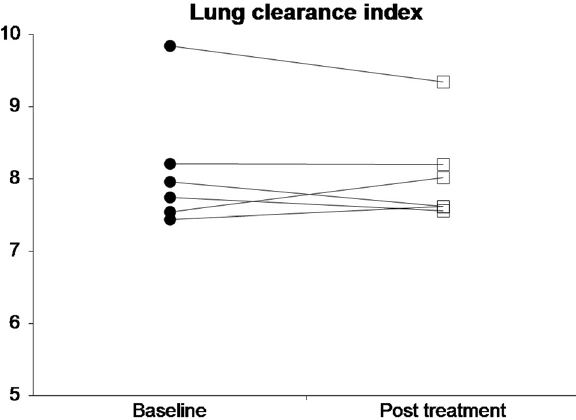
Figure 2. Individual changes in lung clearance index from baseline to post treatment.